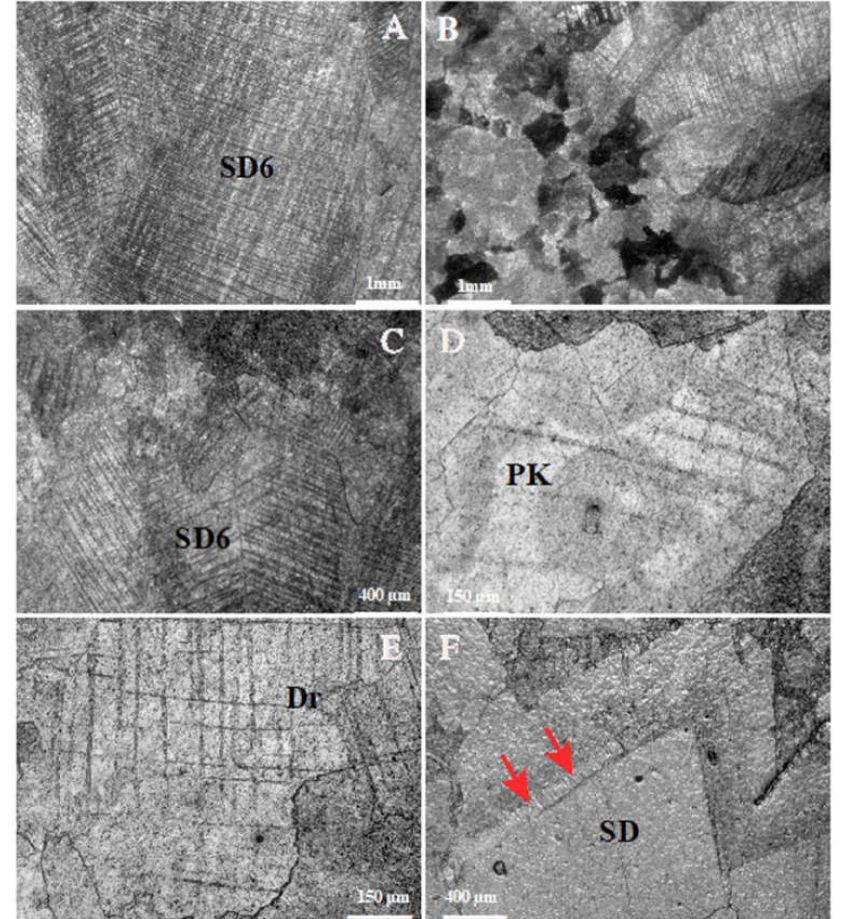
Figure 7. ( A – C ) More than 1mm sized-dolomite crystals SD6 J with two sets of cleavages, precipitated in fractures in contact with recrystallized dolomite. SD6 J shows etching and overgrowth of coarse dolomite. ( D , E ) Saddle dolomite rhomb with an irregular, selectively dissolved outline which predates the poikilotopic texture within the recrystallized dolomite matrix. Two sets of curvature twin laminae, and dissolution of high amplitude stylolite intersecting coarse recrystallized dolomite crystals (the upper side part of Dr and lower side part of E). ( F ) Bladed calcite cement (arrows) precipitated on saddle dolomite crystal: note the trace of calcite across saddle dolomite; such cement strongly refers to late meteoric alteration at near-surface condition. SD, Saddle dolomite; Dr, Dolomite